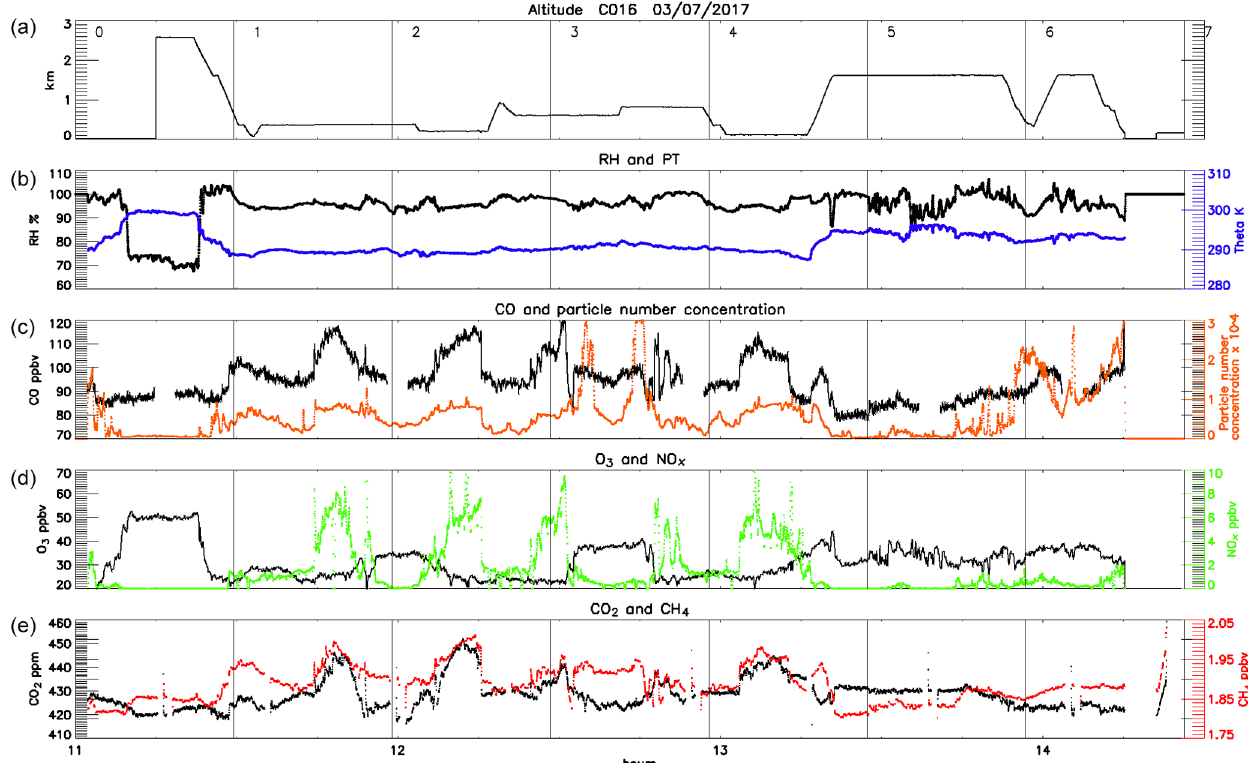
Figure 4. Time series of the main observations during the first flight (3 July, late morning) showing the altitude of the aircraft (a) , relative humidity ( b , black) and potential temperature (blue), CO concentration ( c , black) and particle number concentration (orange), O 3 ( d , black) and NO x (green) concentrations, and CO 2 ( e , black) and CH 4 (red) concentrations. The numbered vertical lines correspond to the numbers along the flight path shown in Fig.